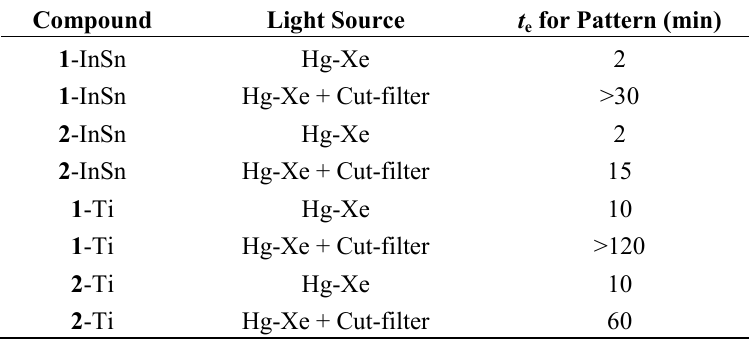
Table 5. Parameters for two-tone